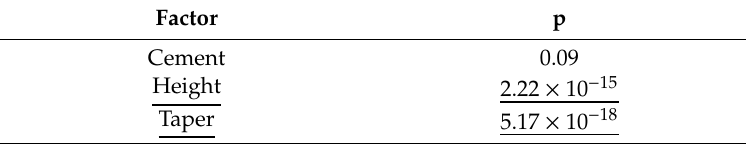
Figure 9. Medians and variability interval of average force value during the removals computed in subgroups divided according to ( a ) luting agent, ( b ) abutment height and ( c ) abutment taper angle. The influence of luting agents and abutment geometry on the number of impulses and average forces of the removals was evaluated by means of three Kruskal–Wallis tests; Tables 1 and 2 show the p -values. Significative factors ( p < 0.05) are underlined. Table 1. Number of impulses needed for retrieval: Kruskal–Wallis (KW) test results.